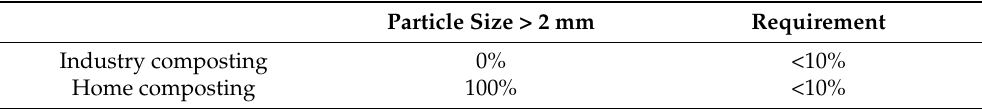
Table 4. Disintegration of the CUT 2 stem support clips under industry (at temperature of 58 °C) and home (at temperature of 30 °C) composting conditions.